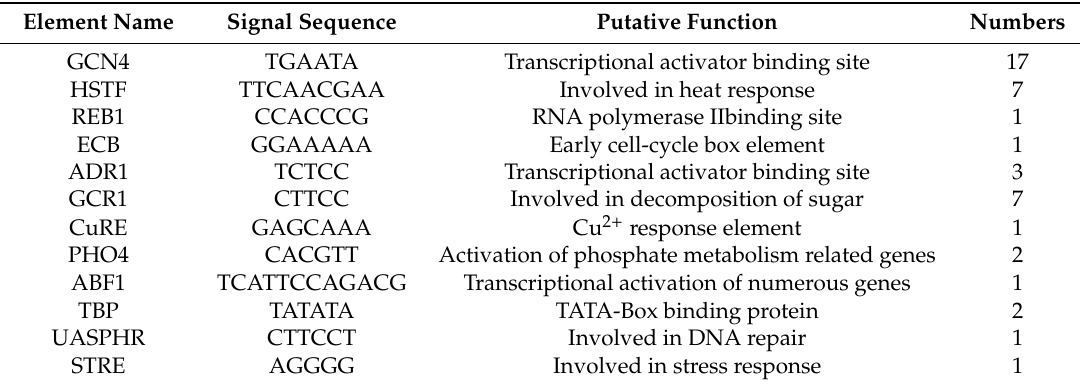
Table 1. The transcription factor binding sites predicted by SCPD.